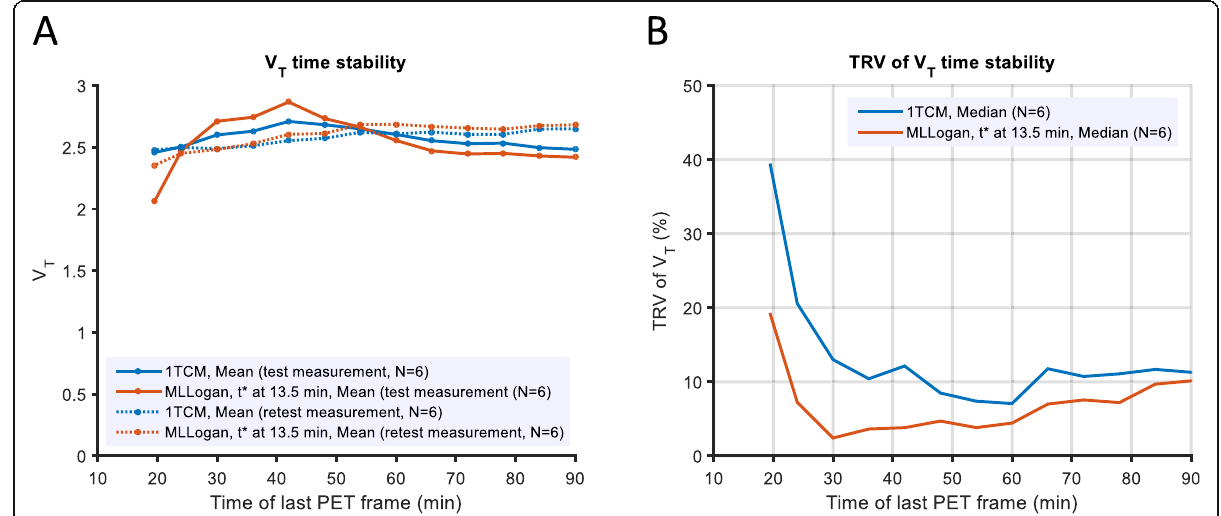
Fig. 6 Time stability of V T measurements for [ 11 C]VC-002. The effect of progressive truncation of measurement time on: a the lung V T mean estimates, and b their repeatability (absolute variability, VAR). Comparison of time stability between one-tissue compartment model (1TCM) and multi-linear Logan graphical analysis